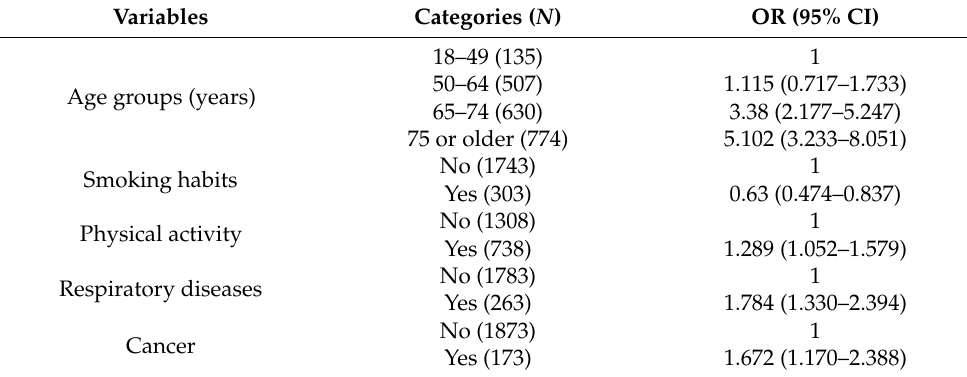
Table 4. Multivariable analysis for vaccine uptake in EHS 2020 for diabetic